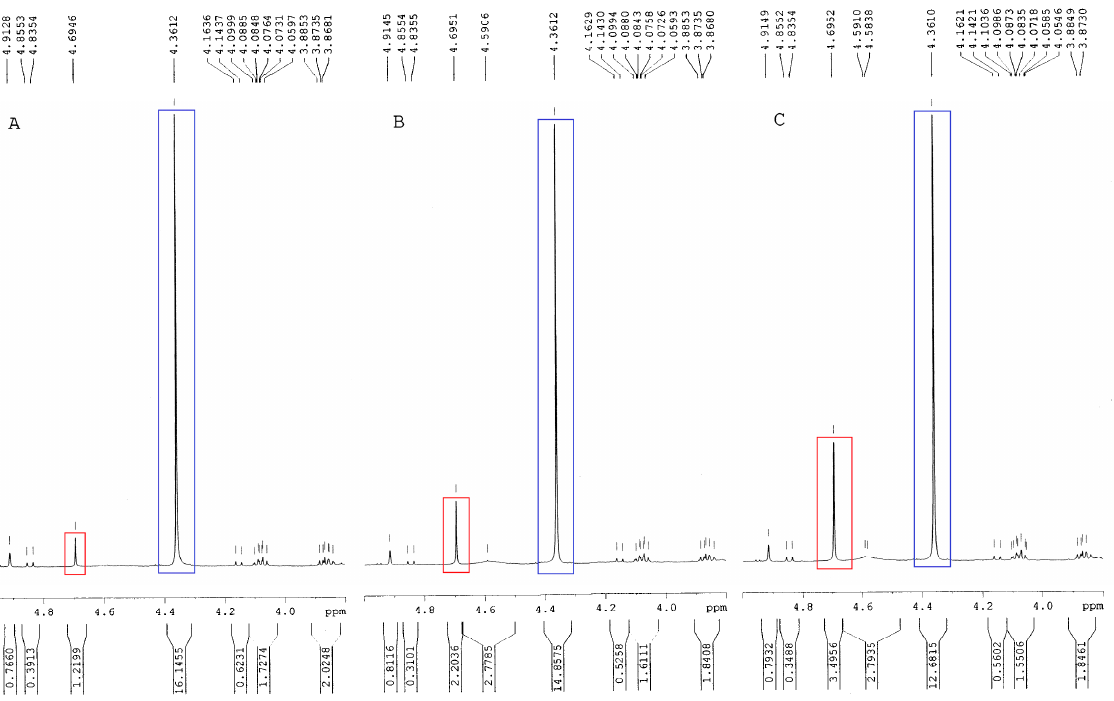
Figure 4. 1 H NMR spectra of a mixture of dibenzo[a.c]phenazine (sensitizer) and 2,3-diphenyl- p -dioxene in CDCl 3 ; irradiation time: A-10 min., B-20 min., and C-30 min.